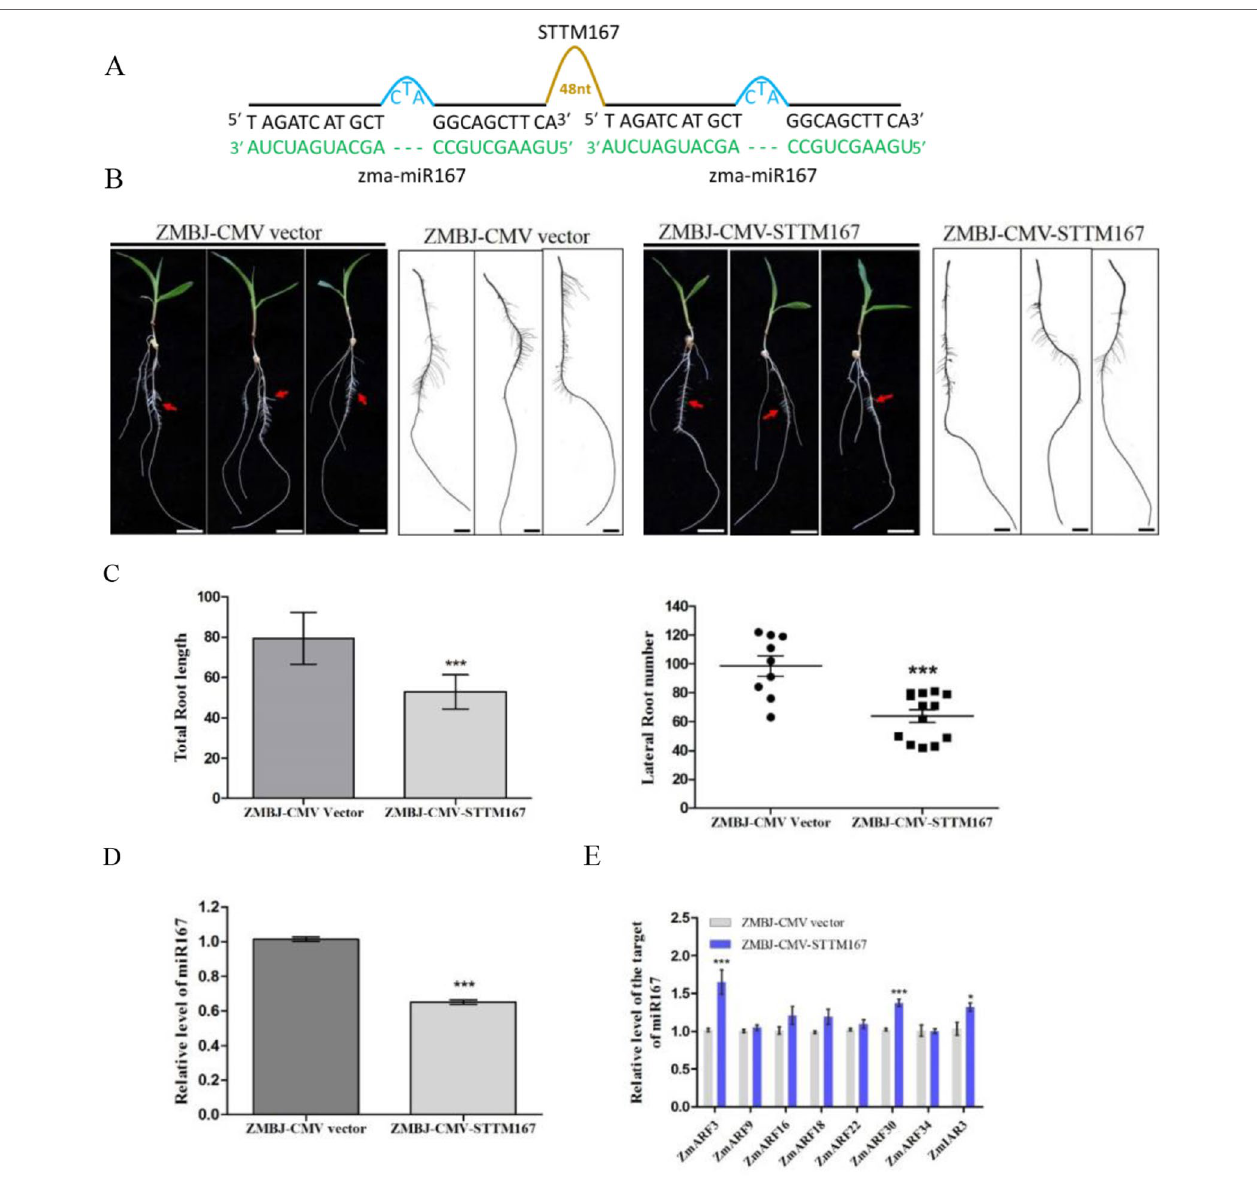
FIGURE 4 | Silencing miR167 expression in maize using ZMBJ-CMV-STTM167. (A) A diagram of the STTM167 insert in the ZMBJ-CMV-based VbMS vector. 48 nt, a 48-nt long stem-loop like linker; —, no nt at this position. (B) Roots of maize seedlings infected with ZMBJ-CMV (control) or ZMBJ-CMV-STTM167 were photographed at 14 dpi. Bars = 2 cm. (C) Measurement of total root length of the ZMBJ-CMV or ZMBJ-CMV-STTM167 infected maize seedlings at 14 dpi. ***, p < 0.001. (D) Relative expression of miR167 in the ZMBJ-CMV or ZMBJ-CMV-STTM167 infected maize plants determined by stem-loop RT-qPCR. (E) Relative expression of miR167 target genes ZmARF3 , ZmARF9 , ZmARF16 , ZmARF18 , ZmARF22 , ZmARF30 , ZmARF34 and ZmIAR3 in the ZMBJ-CMV or ZMBJ-CMV- STTM167 infected maize seedlings. The first true leaves of the assayed plants were harvested at 14 dpi and used for this study. The results were analyzed and presented as described in Figure 2 . *, p < 0.05; ***, p <